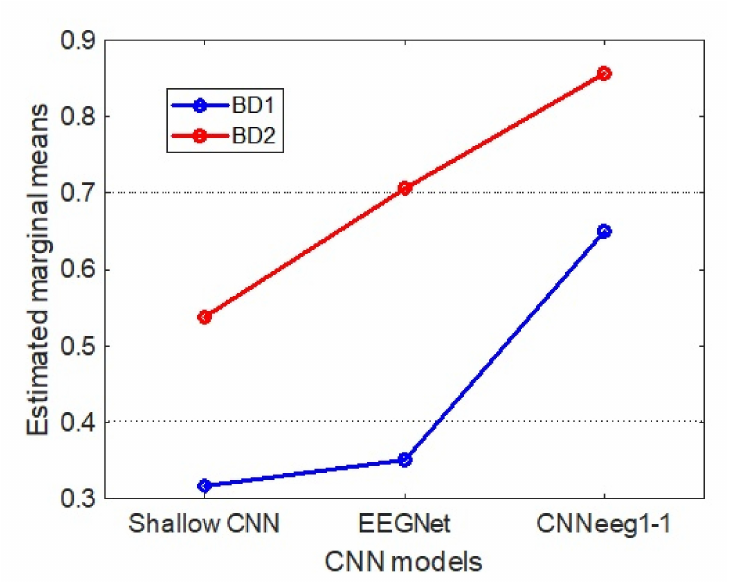
Figure 7. Marginal measures in intra-subject training classification for Shallow CNN, EEGNet, and CNNeeg1-1 algorithms using BD1 and BD2